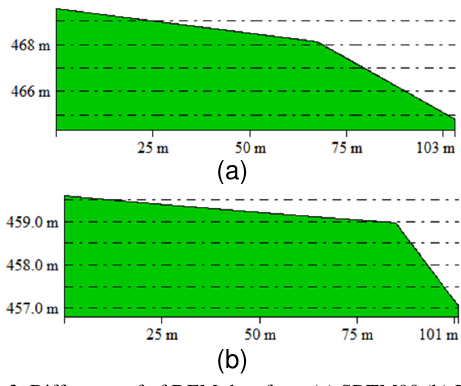
Fig 3. Difference of of DEM data from (a) SRTM90 (b) RBI Fourth profiles were taken on the same segment by segment length + 100m. It can be seen that the difference between TerraSAR-X profile with SRTM90 and DEM RBI so great, even if the SRTM90 and DEM RBI profile relative decline, in the TerraSAR-X profile tends to rise. The y-axis of the profile can also show the level of "error" and DEM SRTM90 RBI, where the maximum height of the TerraSAR-X on that profile only + 452m, whereas in SRTM90 achieve and DEM + 469m + 459m RBI reached.